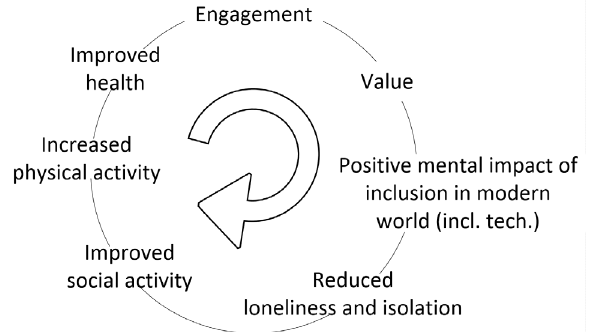
Figure 2. Factors Impacting the Elderly in Technology